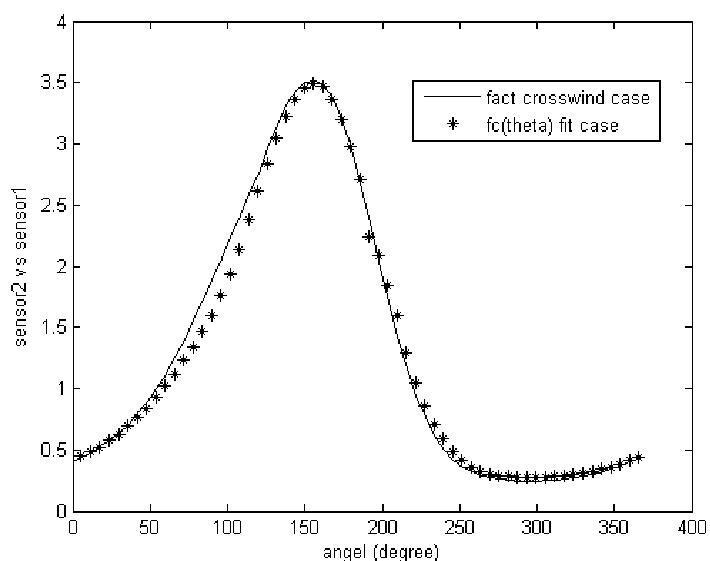
f and original c